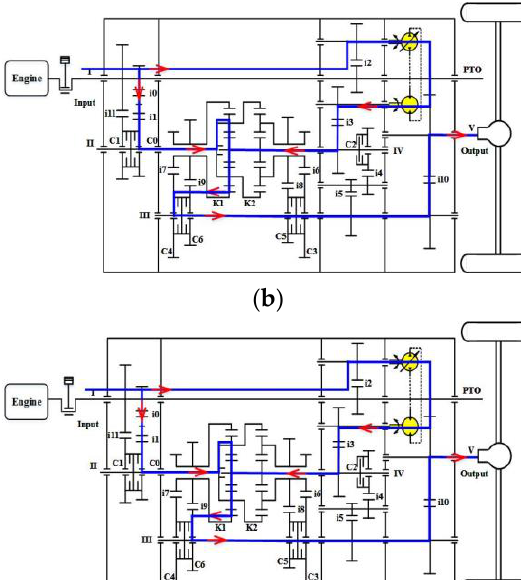
Figure 5. Schematic diagram of HMCVT transmission.